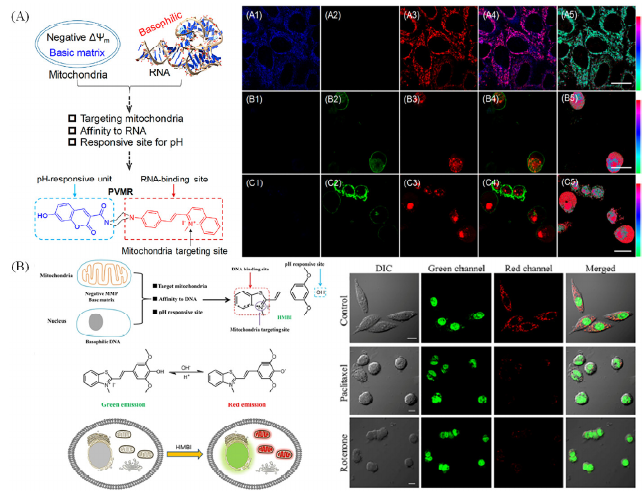
Figure 18. ( A ) Design routes of probe PVMR and the fluorescence and ratiometric images of HepG2 cells co-stained with PVMR and FITV − Annexin V after treatment with diverse culture medium ( A1 − A5 ), paclitaxel ( B1 − B5 ), or rotenone ( C1 − C5 ). A1 – C1 : blue channel pictures; A2 – C2 : green channel pictures; A3 – C3 : red channel pictures; A4 – C4 : Merged pictures of blue, green and red channels pictures. A5 – C5 : ratio pictures of blue and red channels. Reproduced from [95] with permission of the American Chemical Society, copyright 2019. ( B ) Design strategy of probe HMBI and their applications in apoptosis. Reproduced from [96] with permission of the American Chemical Society, copyright